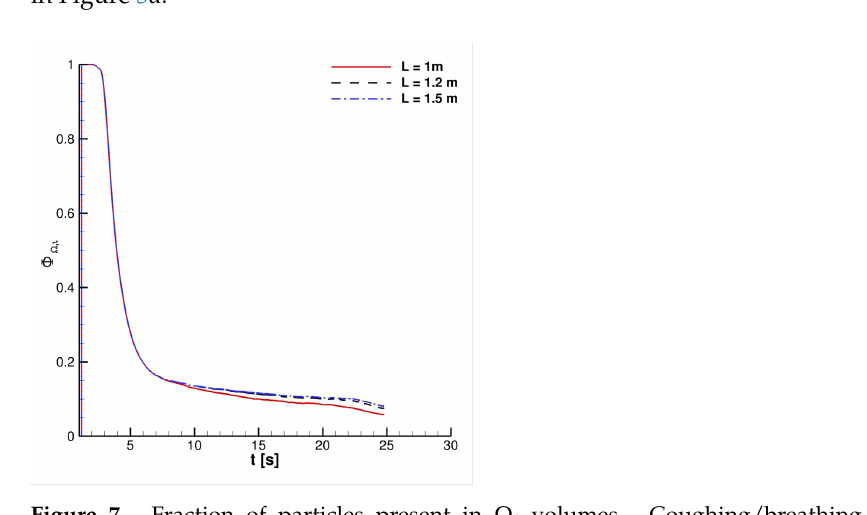
Figure 7. Fraction of particles present in Ω i volumes. Coughing/breathing configuration, Clift configuration.